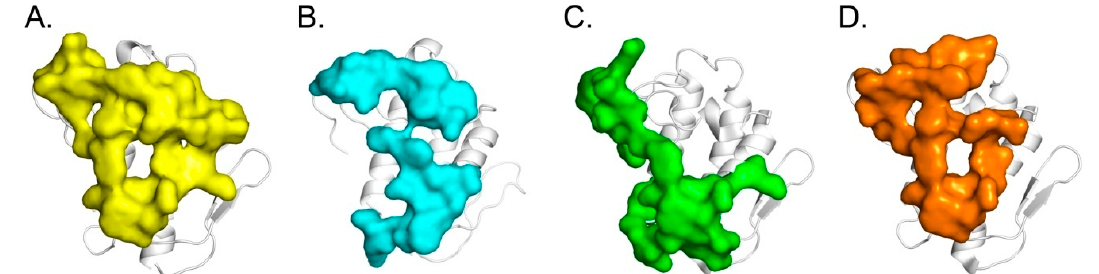
Figure 6. Functional sites of CB, a basal platform for protein-protein interaction. ( A ) CA-binding site identified by crystallography (in yellow) [27], ( B ) CBd-CBd dimer site identified by crystallography (present study, in blue), ( C ) hFXa-binding site generated by molecular docking (in green) [19] and ( D ) Δ F508-NBD1-binding site identified by molecular docking and HDX-MS experiments (in orange) [20].